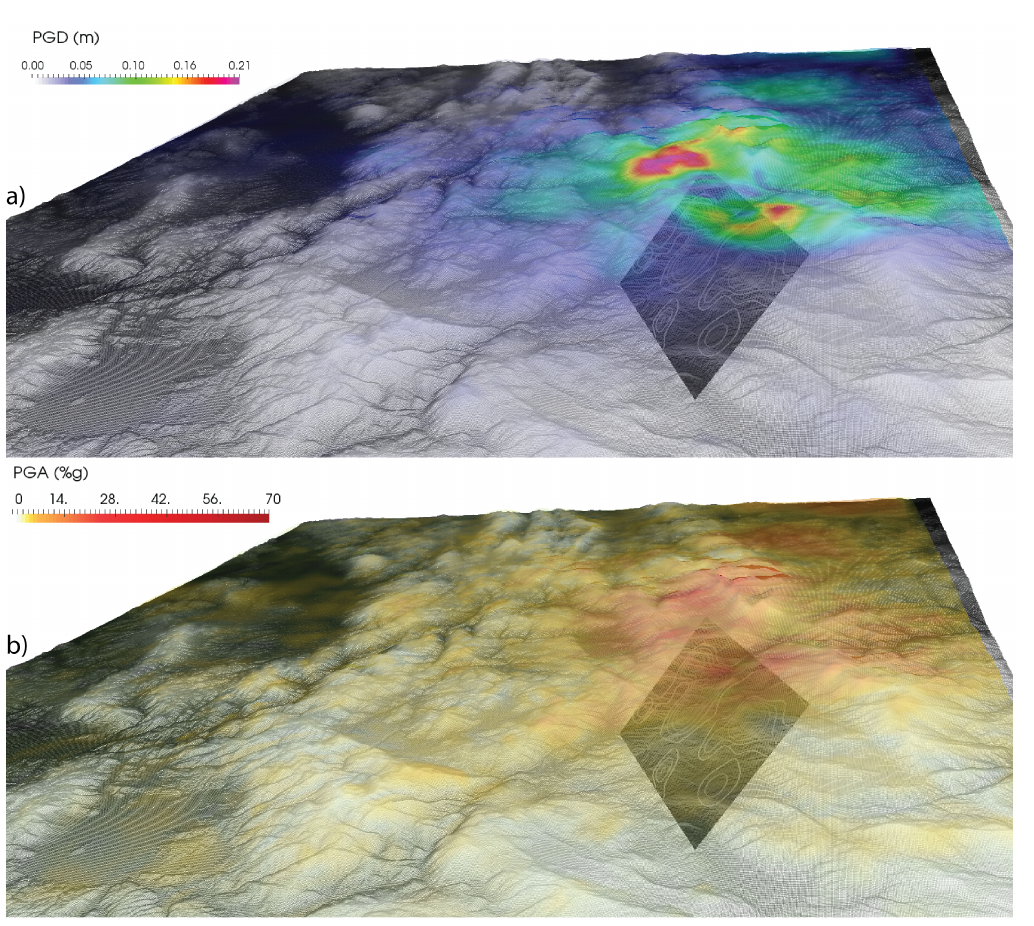
Figure 3: a) Peak ground displacement, express in meters. View from South. The fault plane is in trasparent background with gray contouring of the seismic moment release. b) Peak ground acceleration (frequency up to 0.5 Hz), express in meters. View from South. Both the images highlight the contribution of the topography to the amplification of the seismic wave in the Mt. Vettore